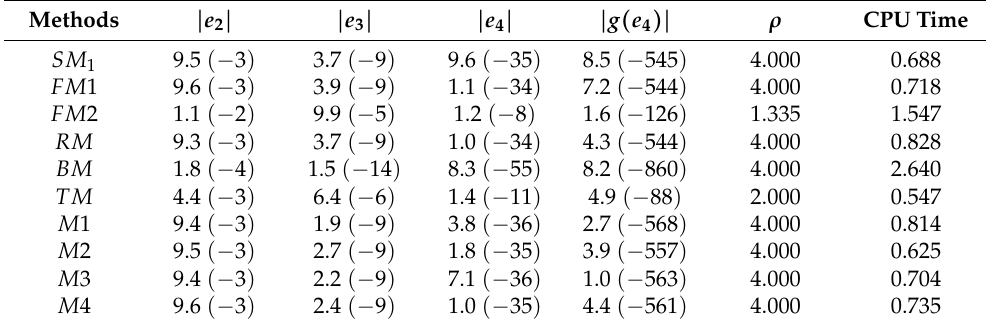
Table 6. The outcomes of Example 4 based on various methods with starting point x 0 = 0.9 i . Methods